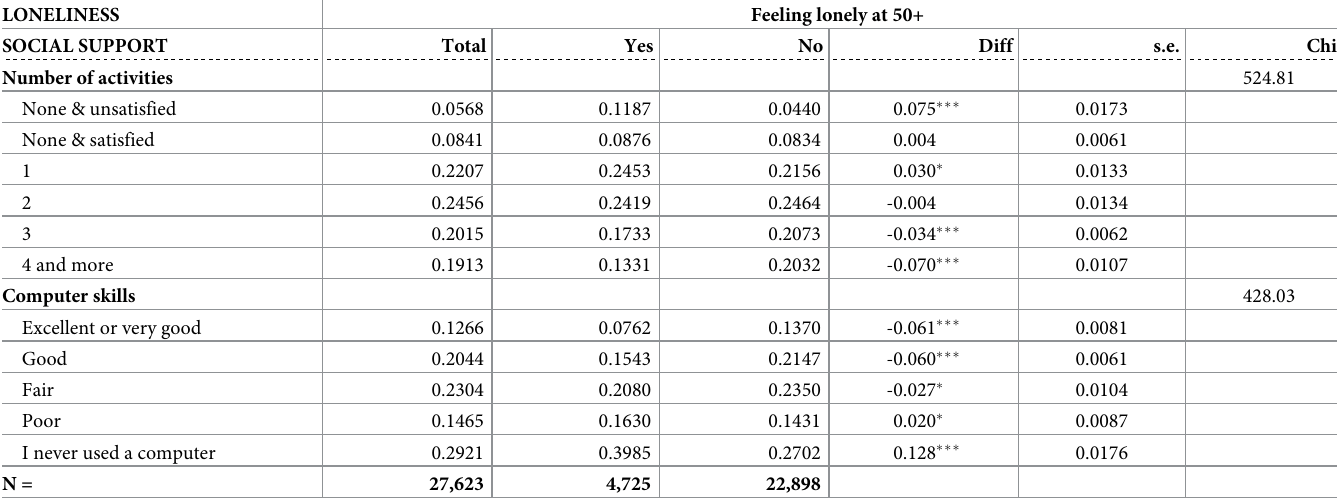
Table 4. Loneliness and social support at age